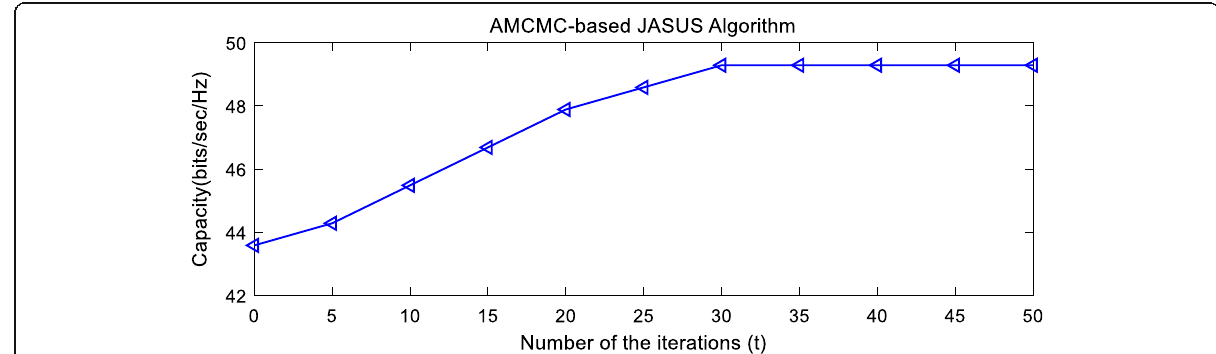
Fig. 4 Ergodic capacity achieved in iterative by AMCMC-based JASUS with B = 7, M = 64, U = 50, N = 16, K = 10, and SINR = 20